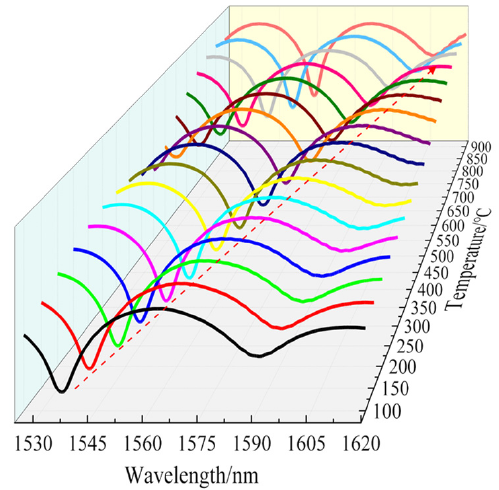
Figure 10. Temperature dependence of the spectrum.